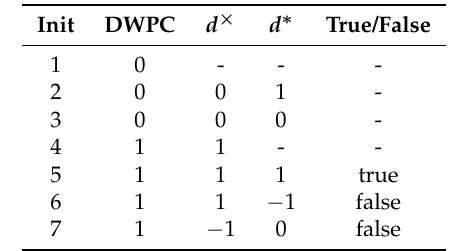
Table 1. Initialization states of the initialization logic of the Dual-Localization